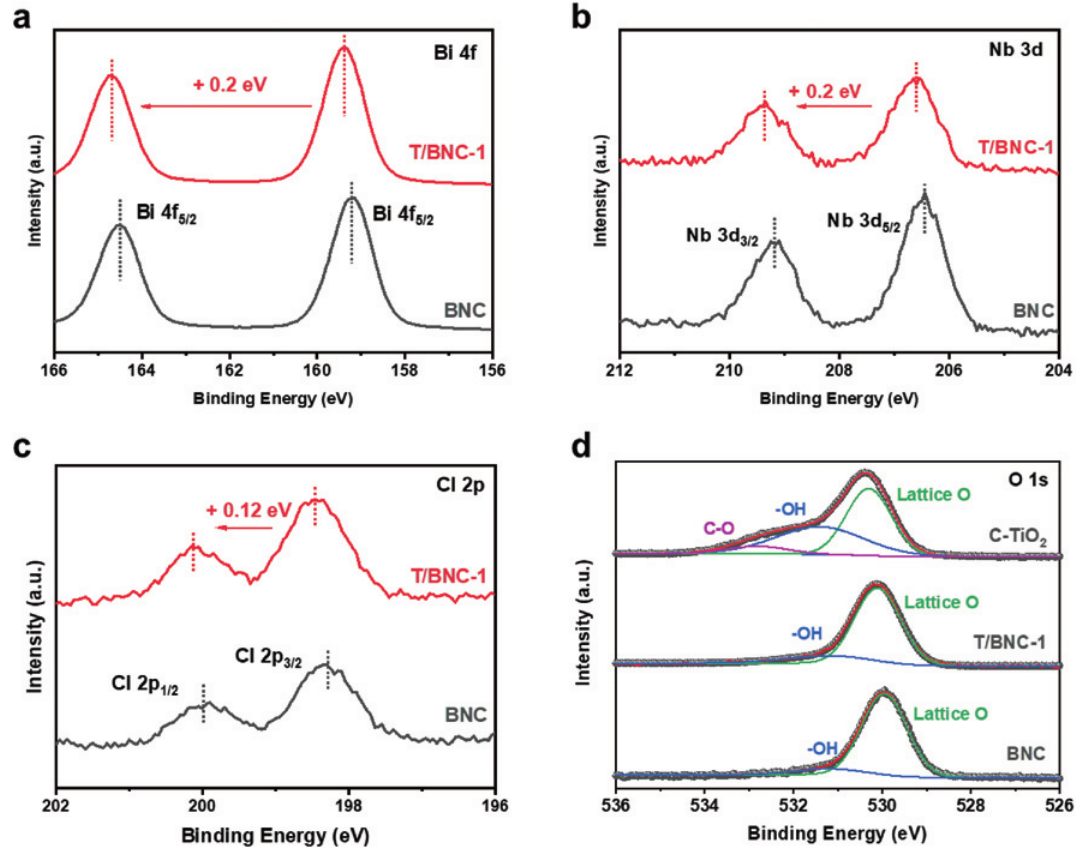
Figure 3: High-resolution XPS of the samples (a) Bi 4f, (b) Nb 3d, (c) Cl 2p and (d) O